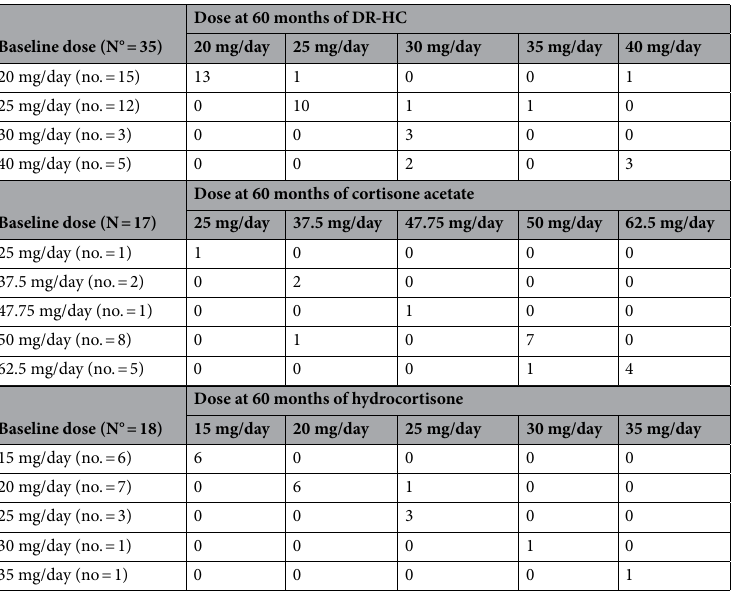
Table 1. Dose adjustments according to the physician’s judgement during the 60 months of conventional glucocorticoid and dual-release hydrocortisone